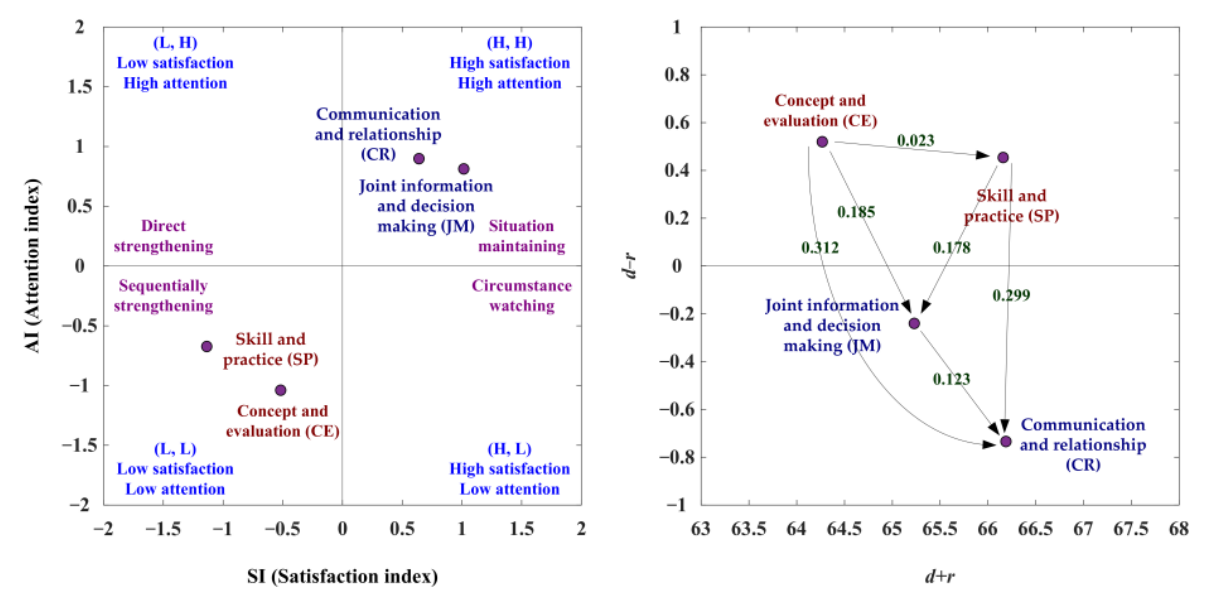
Figure 2. The SAA-NRM analysis of competence development of SDM tasks.